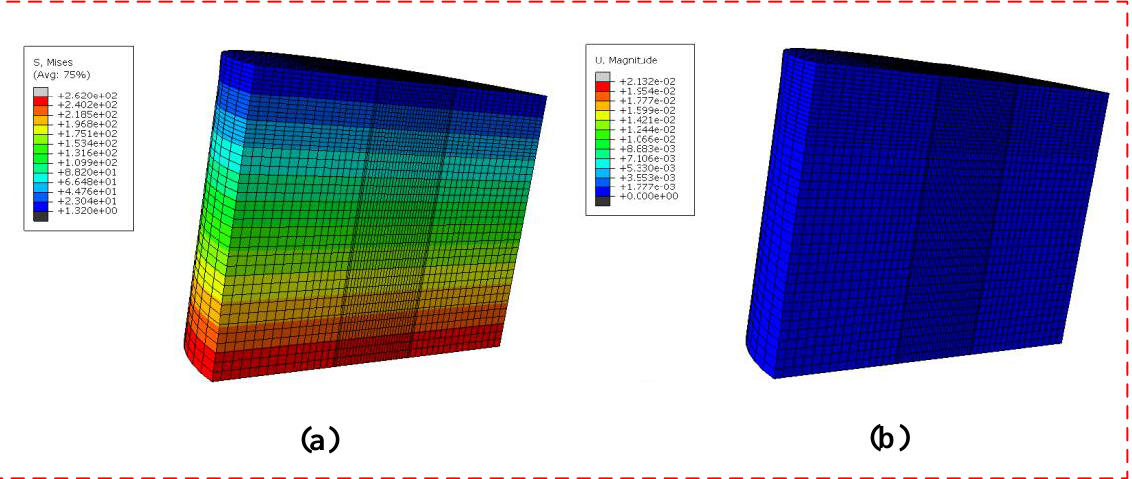
Figure 9. The stress – displacement nephogram after in situ stress equilibrium: ( a ) stress contour; ( b ) displacement contour.